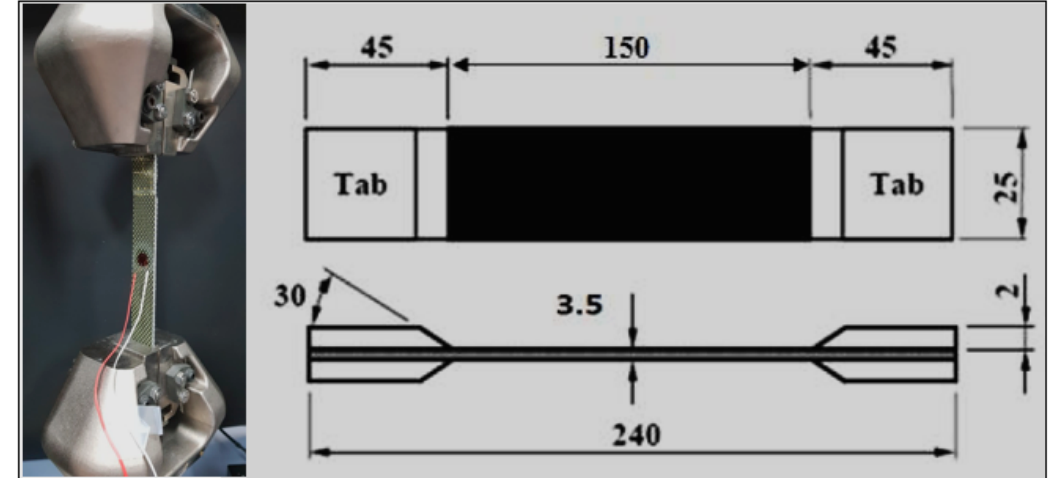
Figure 5. Tensile test and tensile specimen.